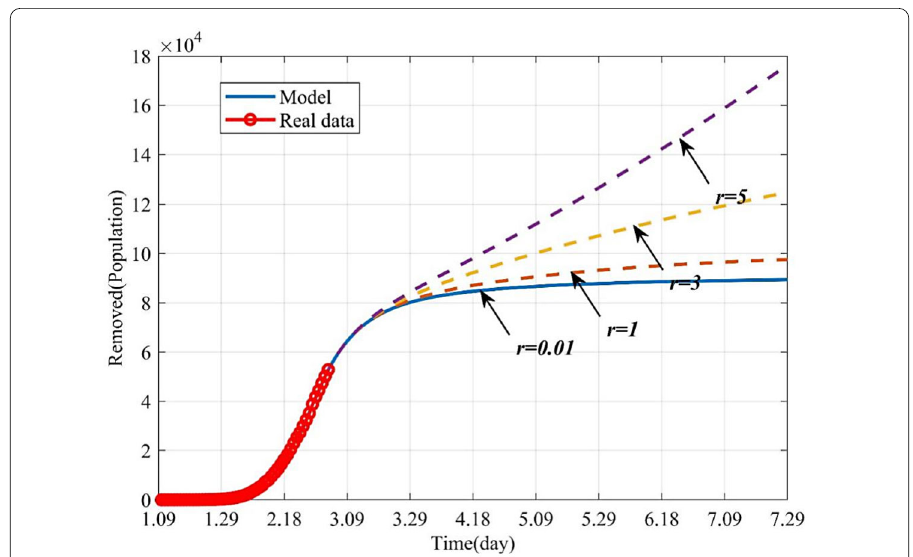
Figure 11 Dynamic trends of the removed with different r . The solid line represents the trends of the removed with the current r . The orange dotted line represents the trends of the removed when r = 1. The yellow dotted line represents the trends of the removed when r = 3. The purple dotted line represents the trends of the removed when r = 5